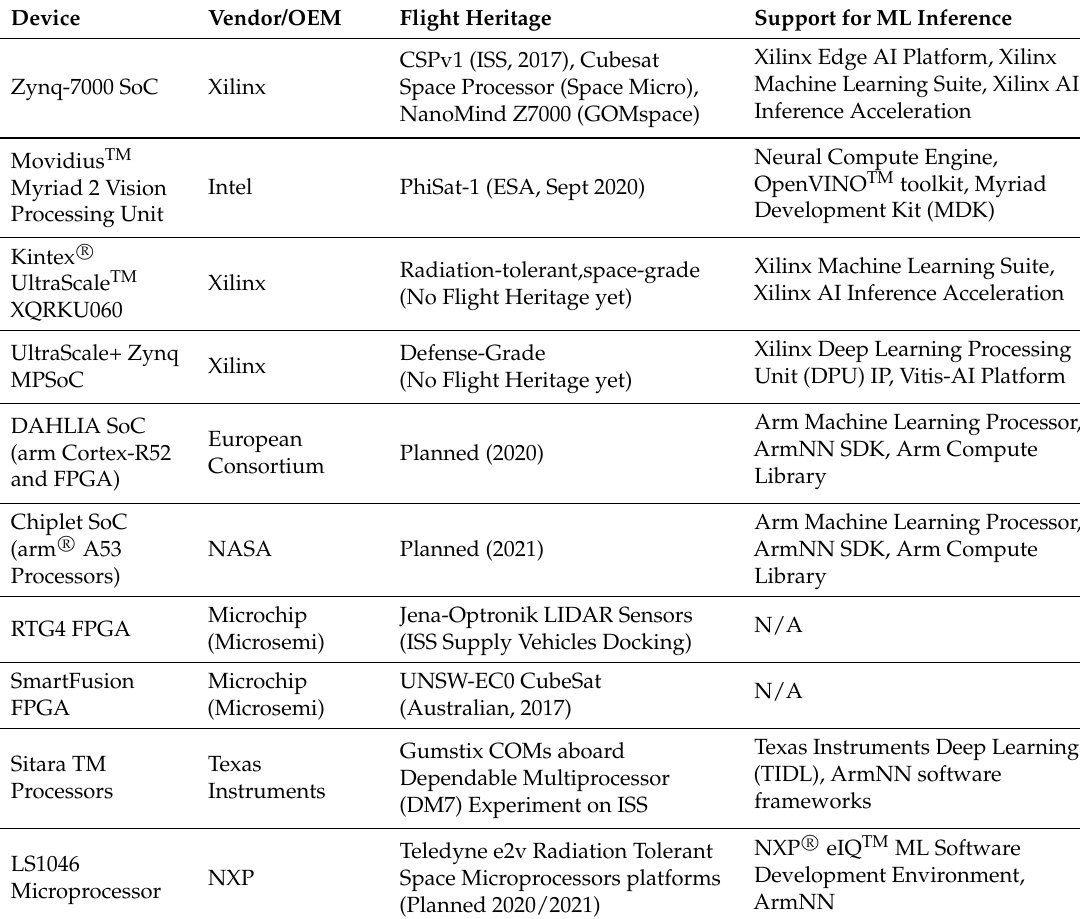
Table 1. Summary of Hardware Suitable for Inference in